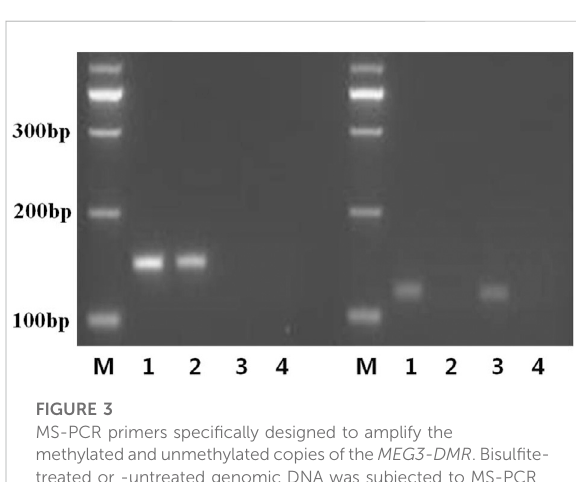
FIGURE 3 MS-PCR primers speci fi cally designed to amplify the methylatedandunmethylatedcopiesofthe MEG3-DMR .Bisul fi te- treated or -untreated genomic DNA was subjected to MS-PCR using the M or U primer pairs separately or multiplexed to generate a 160-bp or 120-bp band from bisul fi te-modi fi ed methylated (left lanes 1, 2) and unmethylated (right lanes 1 and 3) template DNA, respectively. Sample 1: normal control; sample